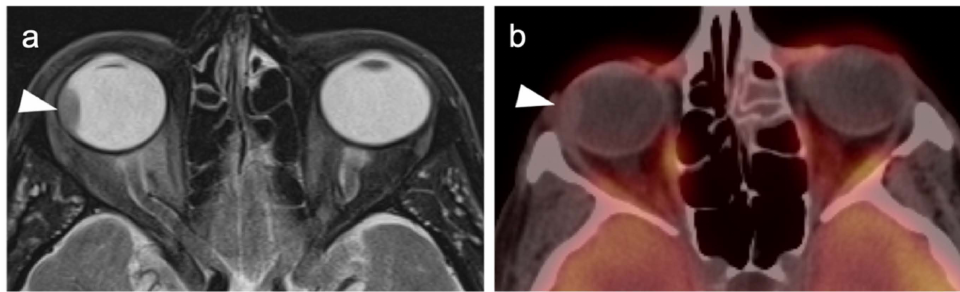
Figure 6. Choroidal melanoma. ( a ) An axial T2 MRI image of the orbits shows a small choroidal melanoma in the lateral inner aspect of the right globe (white arrowhead). ( b ) Axial FDG PET- CT image of the orbits shows no appreciable metabolic activity in the choroidal melanoma (white